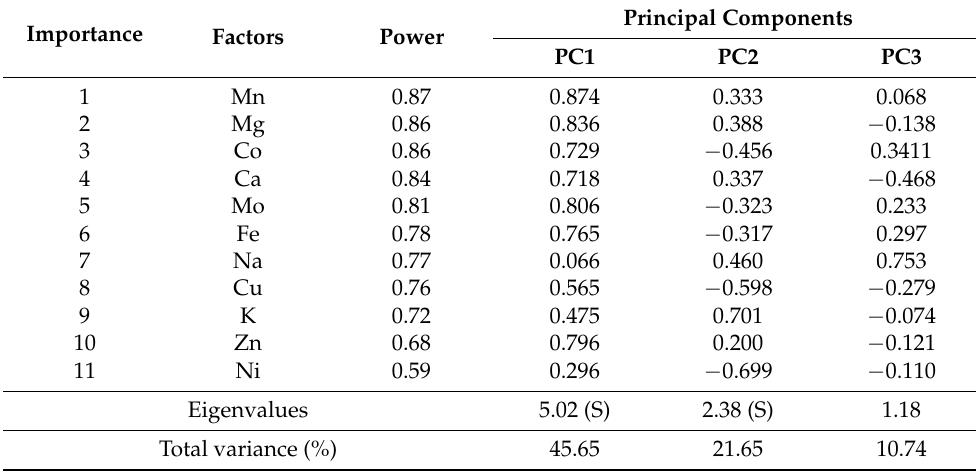
Table 3. PCA results and explained